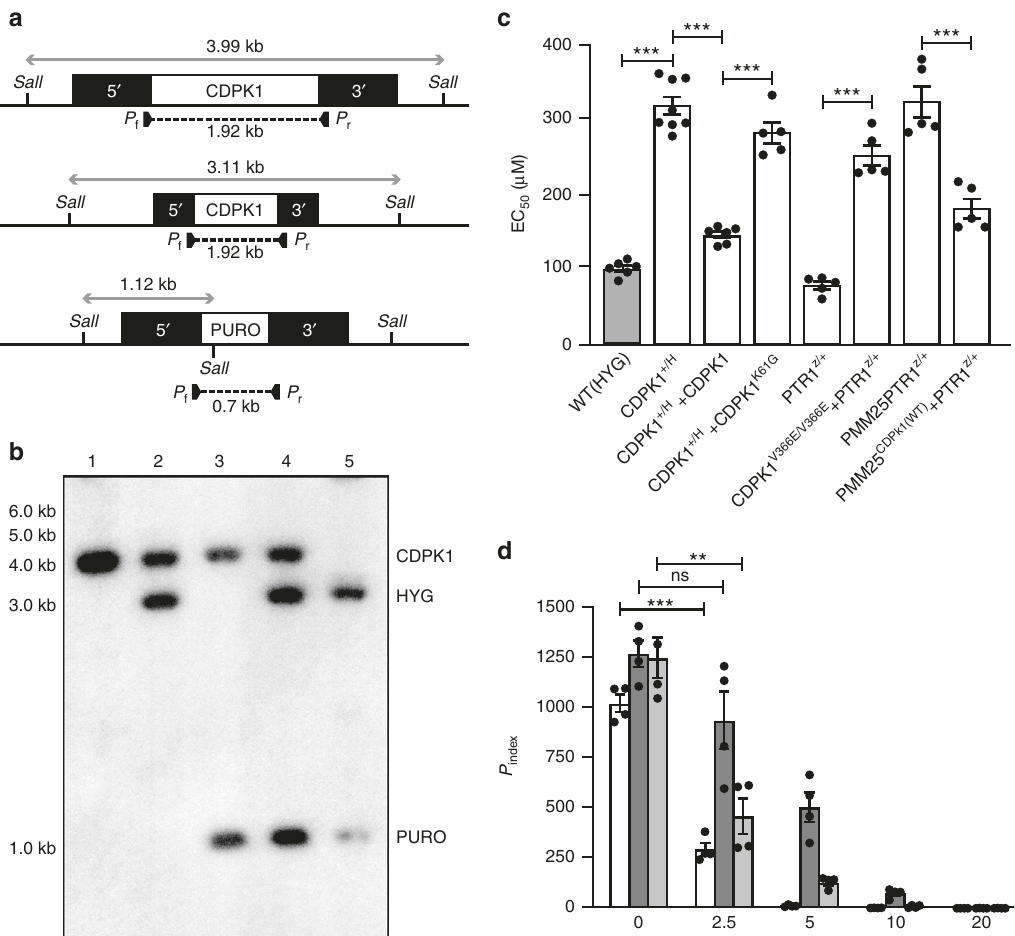
Fig. 3 The essential L. infantum CDPK1 and its role in paromomycin resistance. a Schematic representation of the CDPK1 locus in L. infantum before and after integration of the inactivation cassettes hygromycin phosphotransferase B (5 ′ -HYG-3 ′ ) and puromycin phosphotransferase (5 ′ -PURO-3 ′ ) and expected sizes after digestion with SalI. PCR primers (P f and P r ) and expected size are shown below the map. b Southern blot of DNAs digested with SalI and hybridized with a probe covering 300 bp of the 5 ′ -UTR of CDPK1. L. infantum wild-type strain (1); CDPK1 + /H (2); CDPK1 + /P (3); CDPK1 H/P (4) and CDPK1 H/P + CDPK1 at passage 3 (5). c EC L. infantum cells with various versions of CDPK1 were determined by dose responsive curves against 50 values of PMM. Data are mean ± SEM for n = 8 (CDPK1 + /H ), n = 6 (WT(HYG); CDPK1 + /H + CDPK1) or n = 5 (all other samples) biologically independent replicates. Statistical analyses were performed using unpaired two-tailed t -tests. *** P < 0.001. d Enumeration of activated macrophage (THP1) infectivity and dose responsiveness of wild-type (white) and CDPK1 H/ + recombinant parasites supplemented (light gray) or not (dark gray) with an episomal wild- respectively. Superscript + refers to the wild-type allele. Data represents mean ± SEM for n = 4 independent biological replicates. Statistical analyses